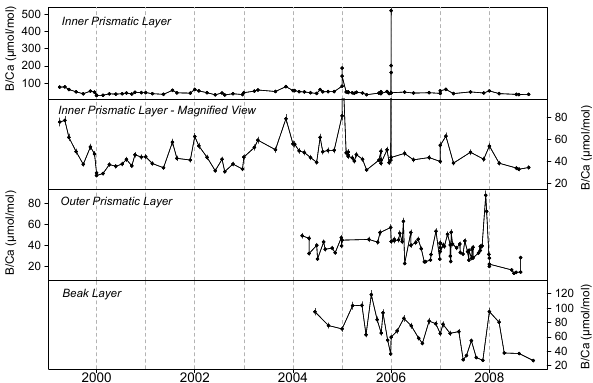
Fig. 6. Plots of complete ion probe B/Ca data from each shell layer, including measurements from winter bands. The locations of winter bands are indicated by vertical dashed shaded lines.